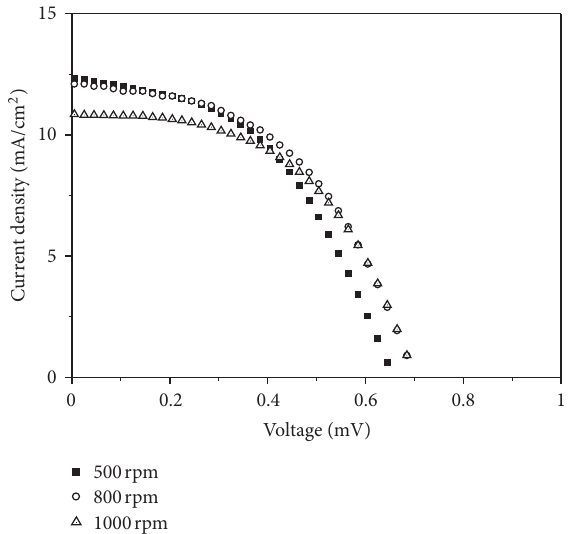
F 3: Photovoltaic curves ( J - V ) of the photoelectrode made at different spinning speeds.